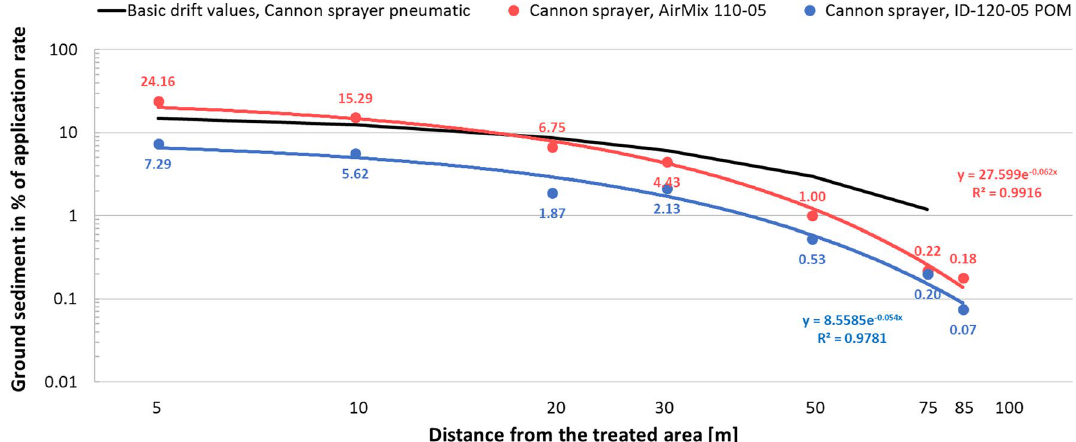
Fig. 4 90th percentile of the cannon sprayer with AirMix 110‑05 and ID‑120‑05 POM compared to the basic drift values of the pneumatic cannon sprayer from ECHA